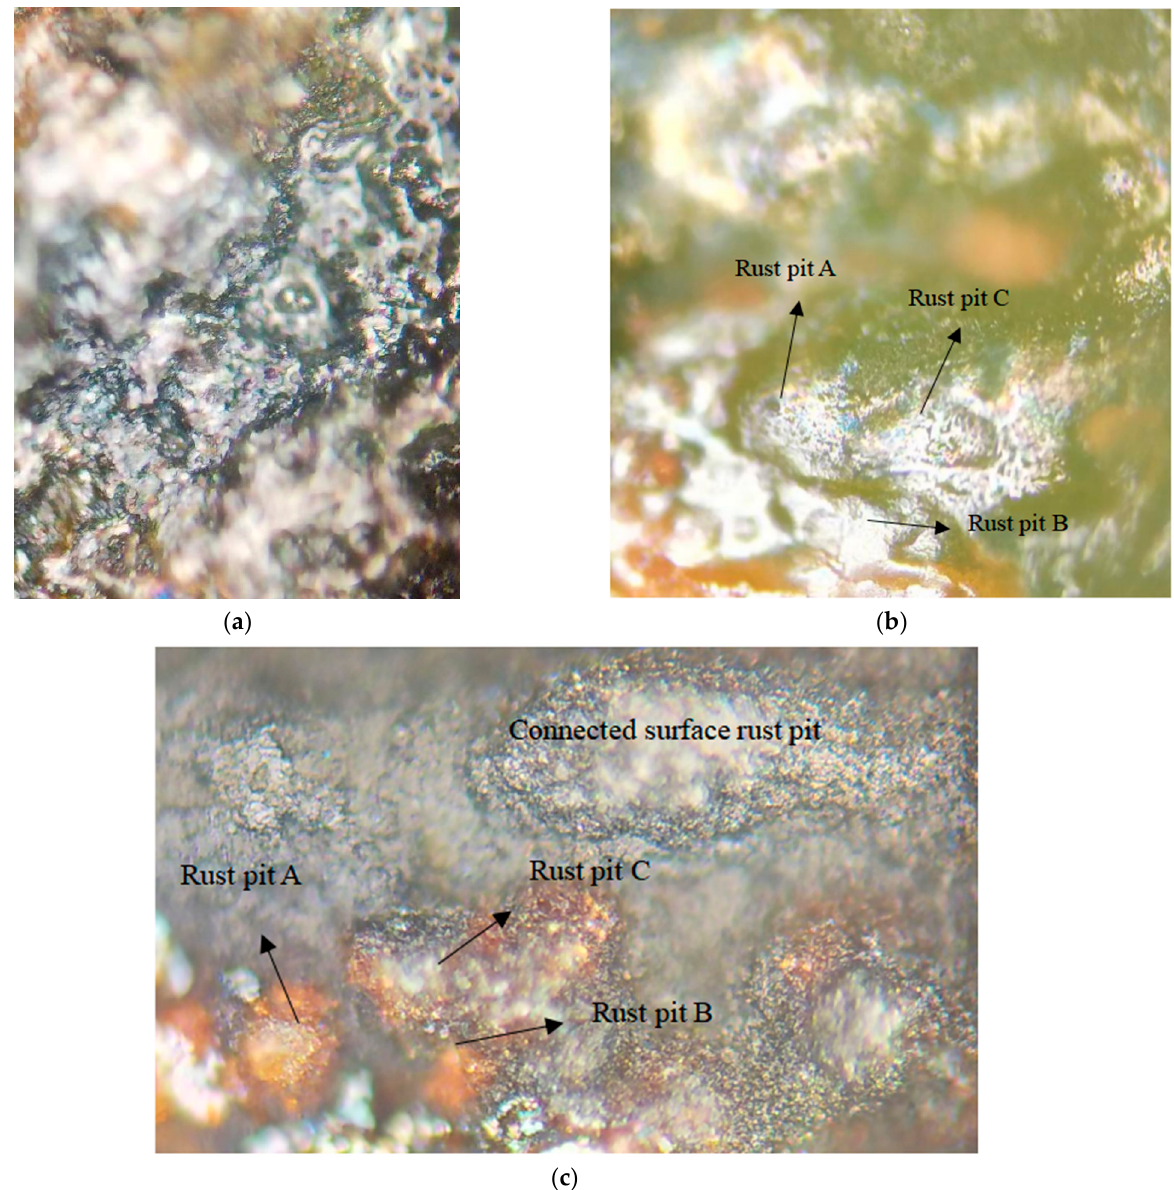
Figure 10. Rusted surface of the reinforcement. ( a ) Distribution of rust pits on the surface; ( b ) adjacent rust pits on the reinforcement surface; ( c ) development of rust pits on the surface of steel bars.